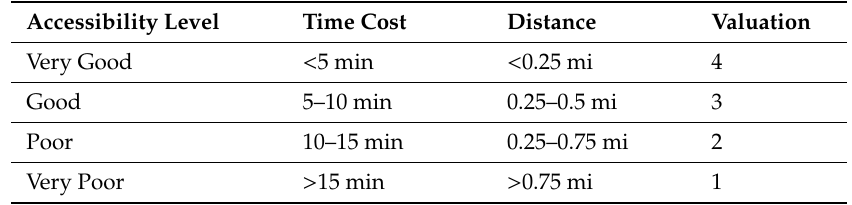
Table 2. Reference standards of time-cost accessibility